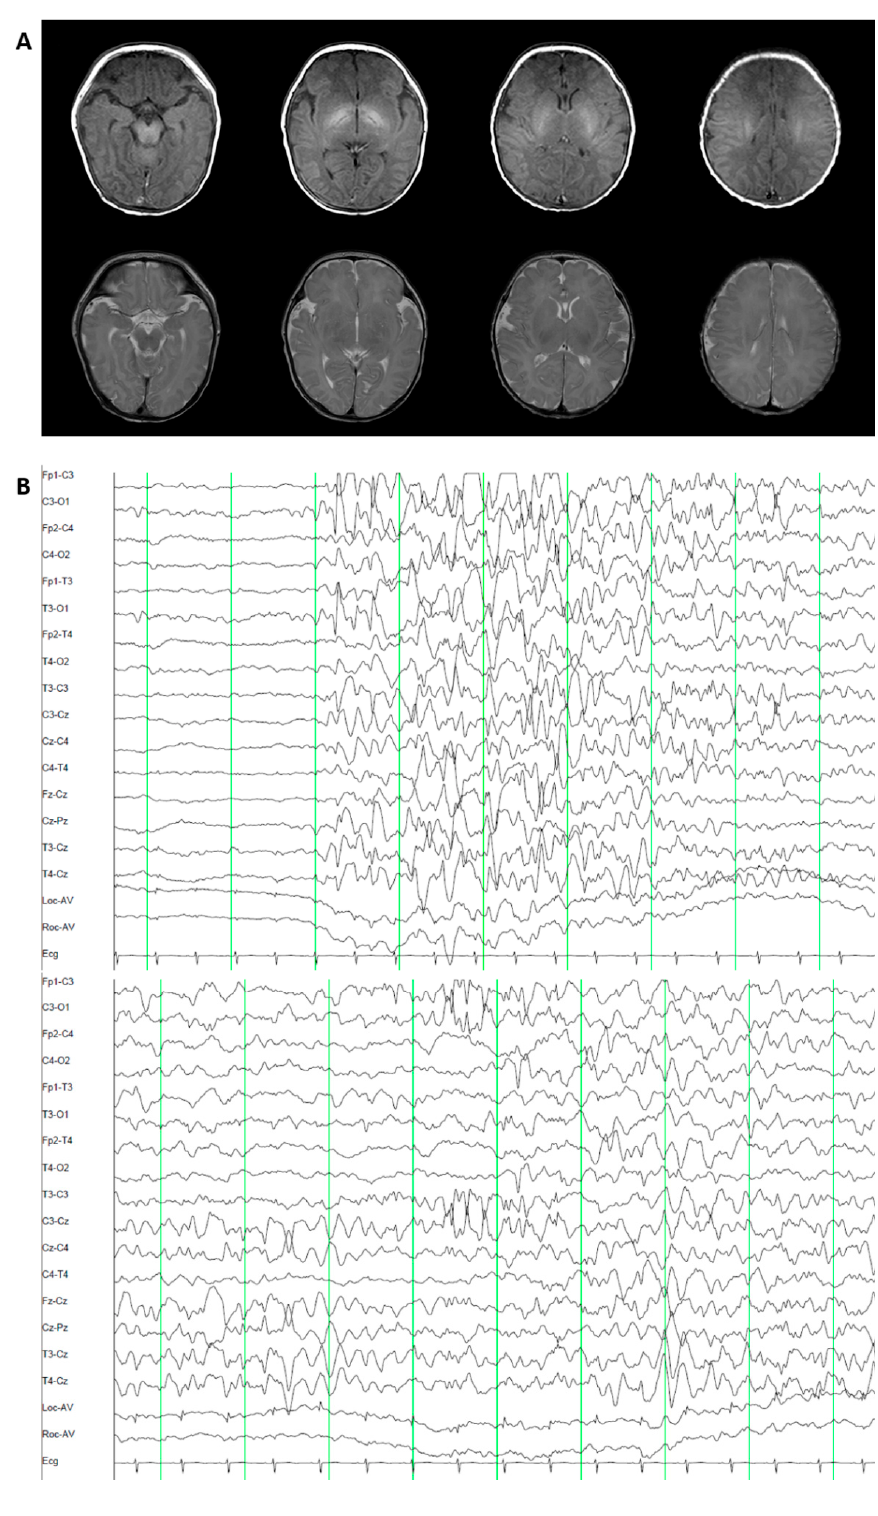
Figure 2. Brain Magnetic Resonance imaging (MRI) and Electroencephalography (EEG) findings of patient 3 at 4 days after birth. ( A ) The T1 (first row) and T2 (second row) images were normal. ( B ) The EEG shows an intermittent suppression-burst background ( top ) and occasional sharp wave discharges from the left occipital and central head areas ( bottom ).